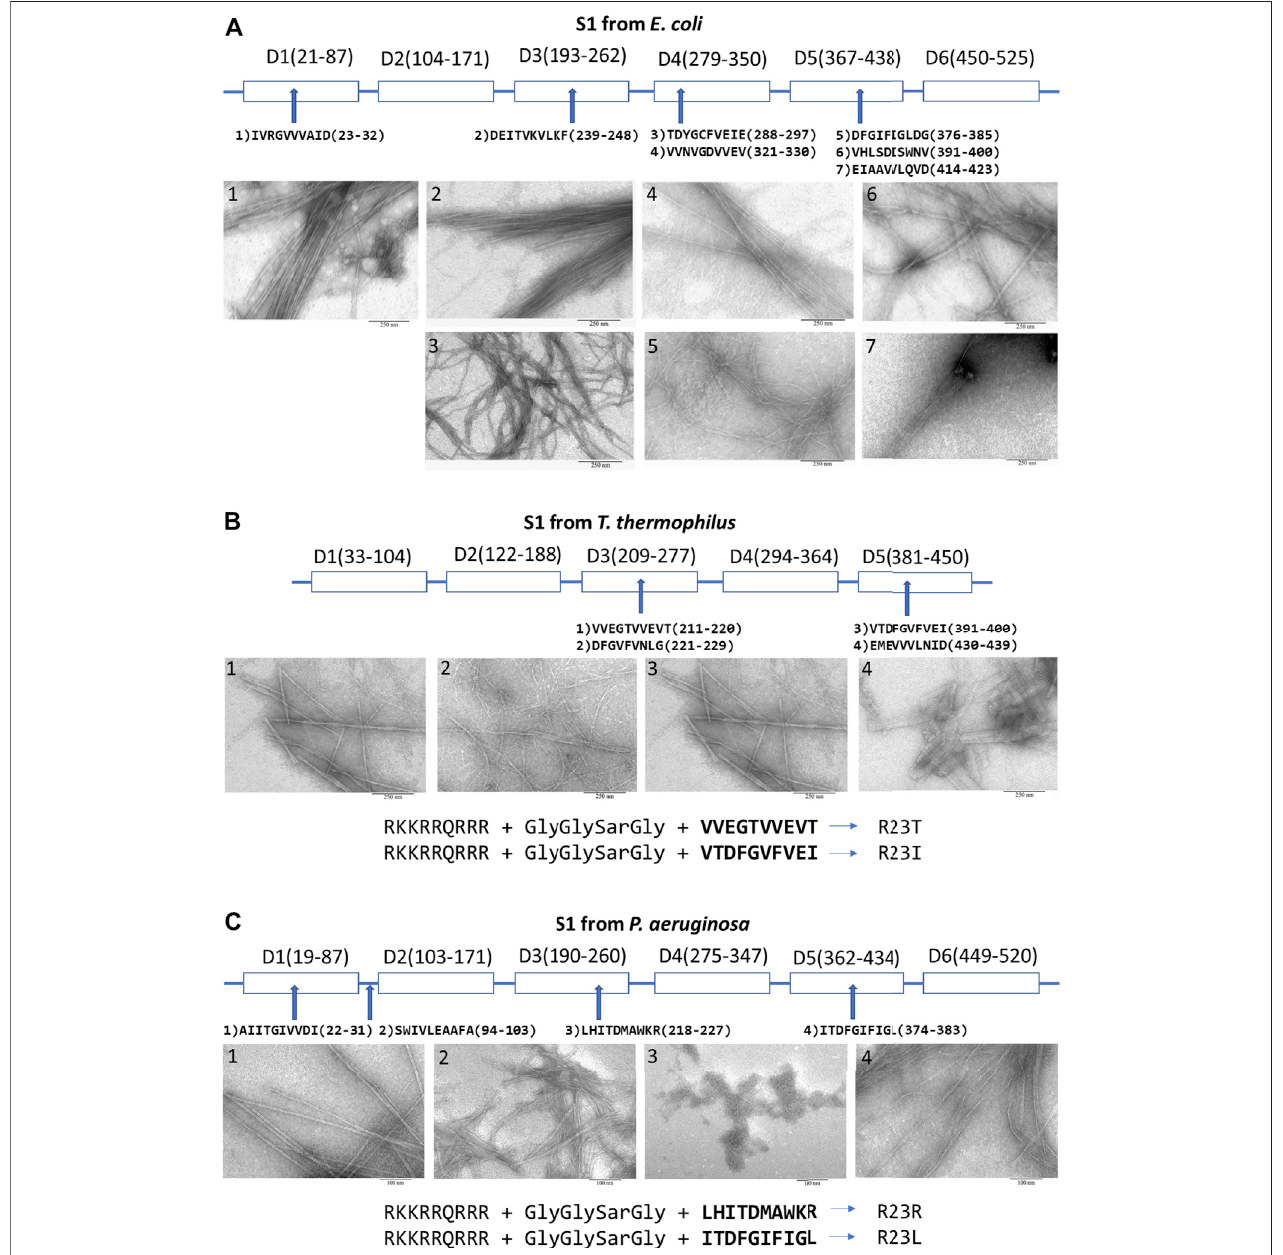
FIGURE 2 | Peptides prone to aggregation from the ribosomal S1 protein. From (A) E. coli ; (B) T. thermophilus (Grishin et al., 2020b); (C) P. aeruginosa (Grishin et al., 2021). Scale bar is 250 nm for (A) , (B) and 100 nm for (C) . Amyloidogenic regions were predicted by using four programs: FoldAmyloid, Waltz, PASTA2.0, and Aggrescan (see Supplementary Material